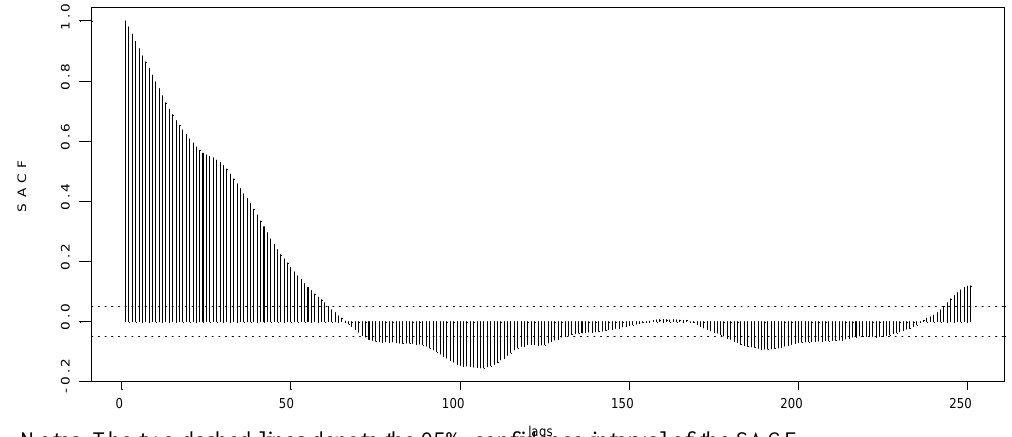
Figure 3: Sample autocorrelation of cointegration residual series between China and HK ACF of cointegration residual between China and HK